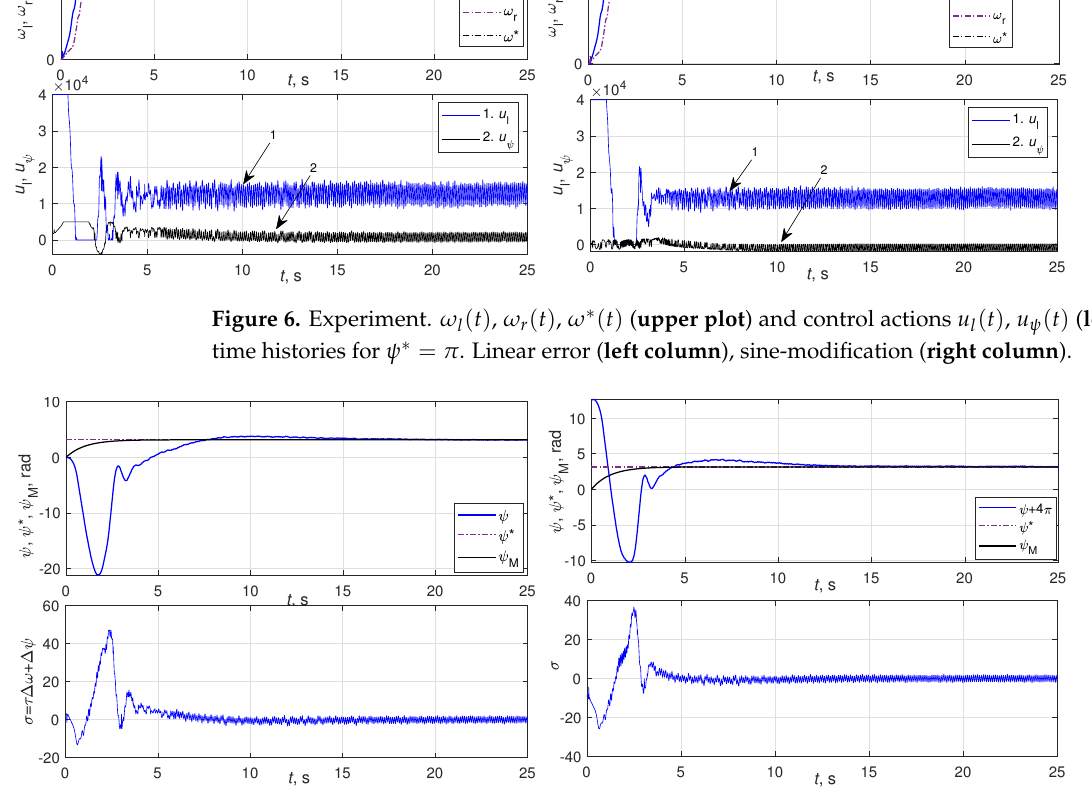
Figure 7. Experiment. ψ ( t ) , ψ ∗ , ψ M ( t ) ( upper plot ) and IMR discrepancy signal σ ( t ) ( lower plot ) time histories for ψ ∗ = π . Linear error ( left column ), sine-modification ( right column